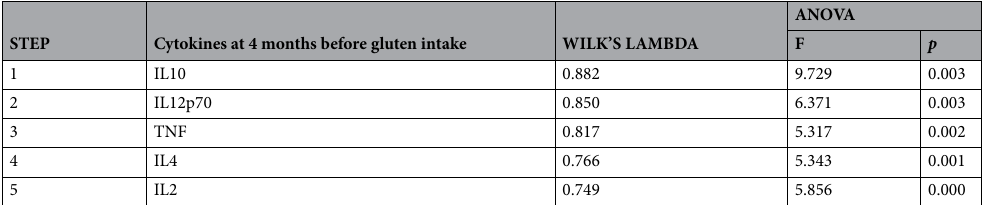
Table 1. Serum cytokine discriminant analysis at 4 months, before gluten introduction, between celiac disease patients (CD) and controls (CTRLs). Wilk’s lambda estimates of the capacity of each serum cytokine to discriminate between the groups once all other cytokines are considered. F is the variance ratio estimated at each step of the analysis.